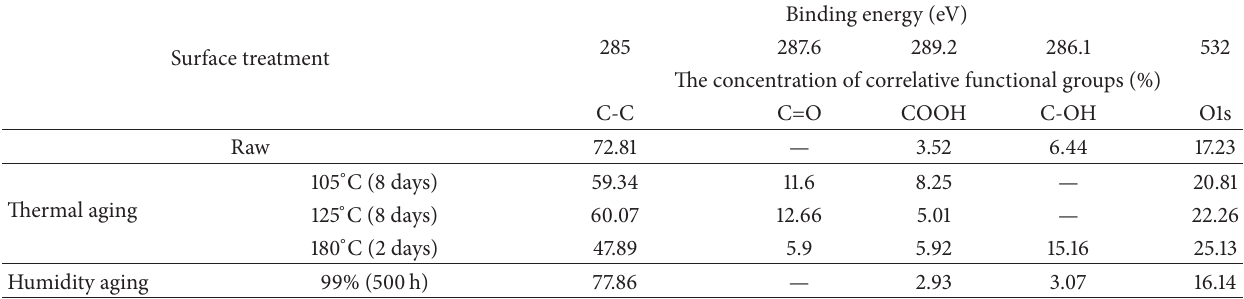
Table 4: Surface functional groups analyzed by XPS of the polyketone/NR composite as thermal aging and humidity aging.